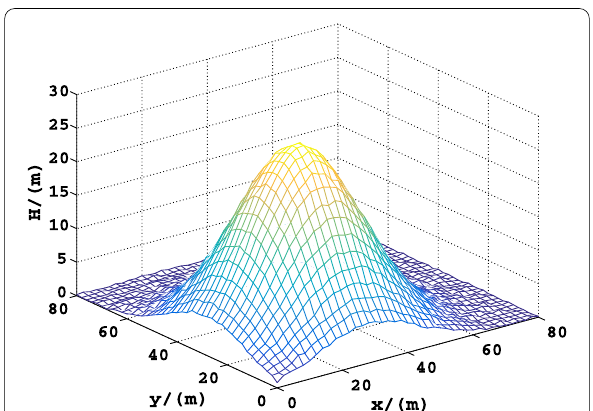
Fig. 7 DTM model disturbed by MREs with σ m = 0.005 in the third example